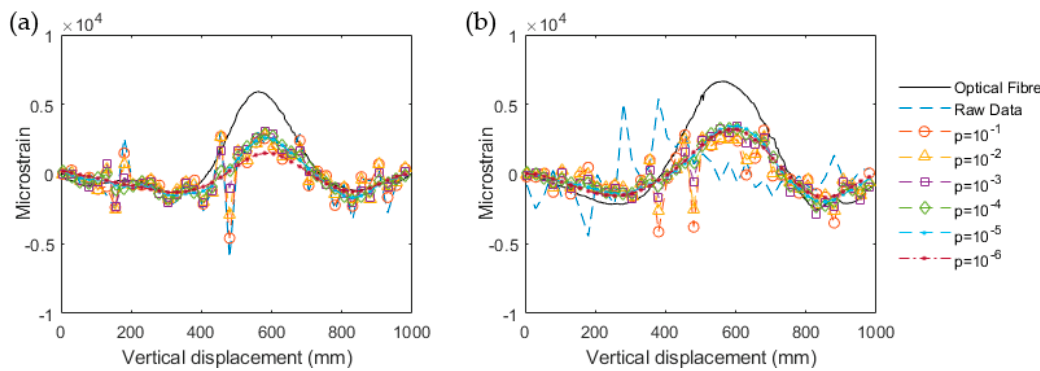
for different (cid:1868) parameters, no filter, and optical fibre.